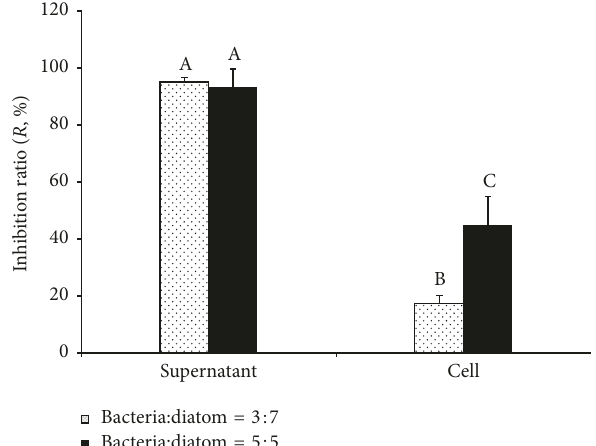
Figure 4: Activities against diatom biofilm formation by bacterium Psychrobacter sp. with different portions. The numbers of 7: 3 or 5 :5 indicate the volume ratios with which diatom Stauroneis sp. in suspension was mixed with the supernatant or cells suspension in the fresh culture medium. The inhibiting ratios ( R ) were calculated after 24 h incubations. Triplicates were tested for each treatment and control, and the means and standard deviations are shown as columns and bars, respectively. Significance was tested for each treatment separately. Same/different letters above the bars indicate no/a statistical difference in determination by one-way analyses of variance (ANOVA) followed by LSD test ( P 0 . 01), respectively. <